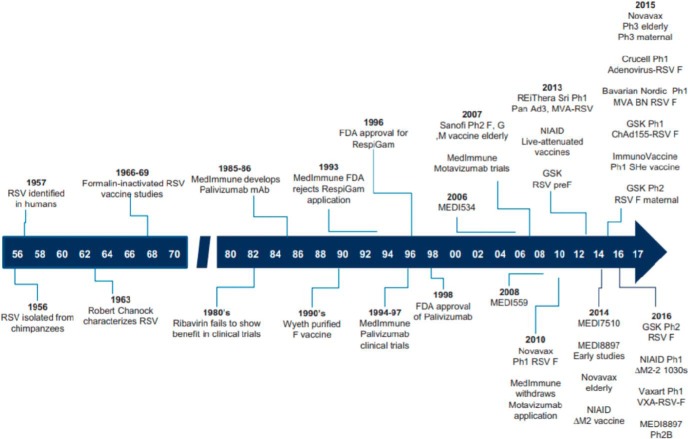
History of Respiratory Syncytial Virus Vaccine and Monoclonal Antibody Research3Abbreviations: BN, Bavarian Nordic; ChAd, chimpanzee-derived adenovirus; F, respiratory syncytial virus fusion protein; FDA, United States Food and Drug Administration; GSK, Glaxo Smith Kline; mAb, monoclonal antibody; MEDI; MedImmune; MVA, modified vaccinia Ankara; NIAID, National Institute of Allergy and Infectious Diseases; PanAd, simian adenovirus; Ph, phase; RSV, respiratory syncytial virus; VXA, Vaxart.